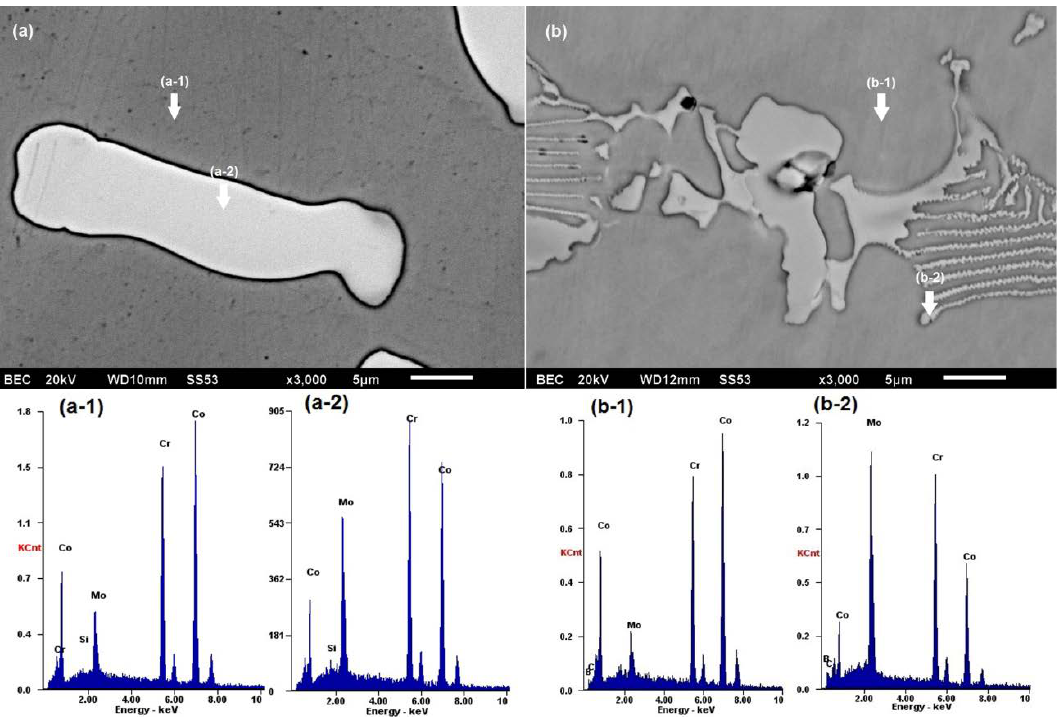
Figure 3. Scanning electron microscopy (SEM) images of the microstructures of alloys with ( a ) 0B and ( b ) 1B and EDS on the matrix and precipitates.